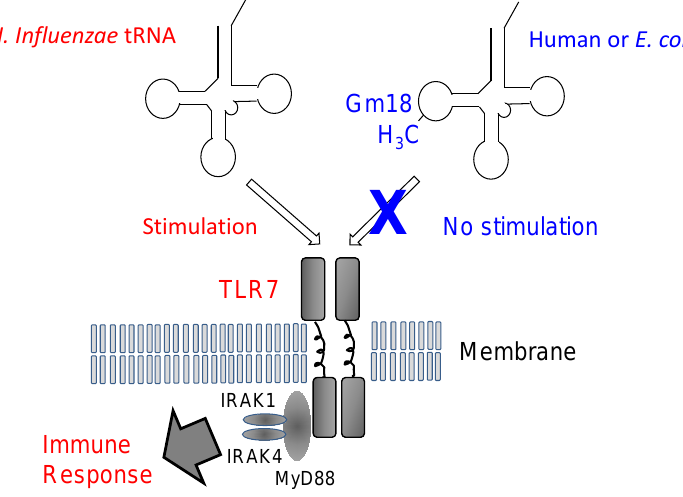
Figure 8. Model of the immune response and Gm18 methylation in tRNA. Transfer RNA from H. influenzae , a respiratory infectious bacterium, induces dimer formation by Toll like receptor-7 (TLR7), the immune response is then stimulated via binding of the proteins, MyD88, IRAK1 and IRAK4. In contrast, human and E. coli tRNAs do not stimulate TLR7 because they contain the Gm18 modification. The E. coli trmH gene disruptant strain does not show any obvious phenotype under laboratory culture conditions [7]. Both Gm18 modification and TrmH are required for survival of E. coli in animal